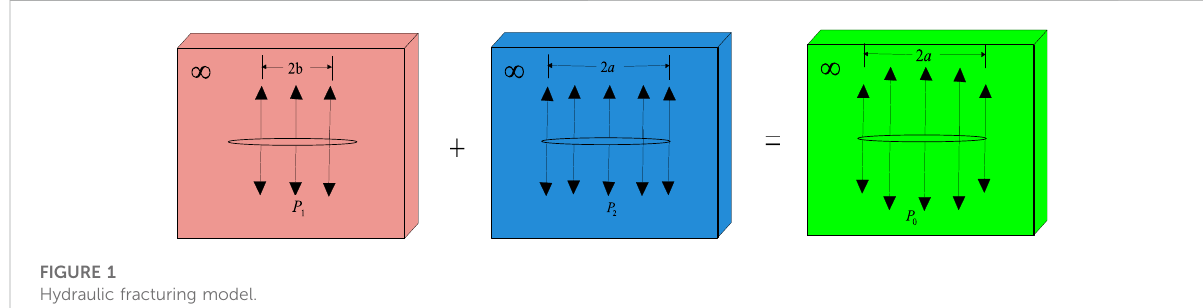
FIGURE 1 Hydraulic fracturing